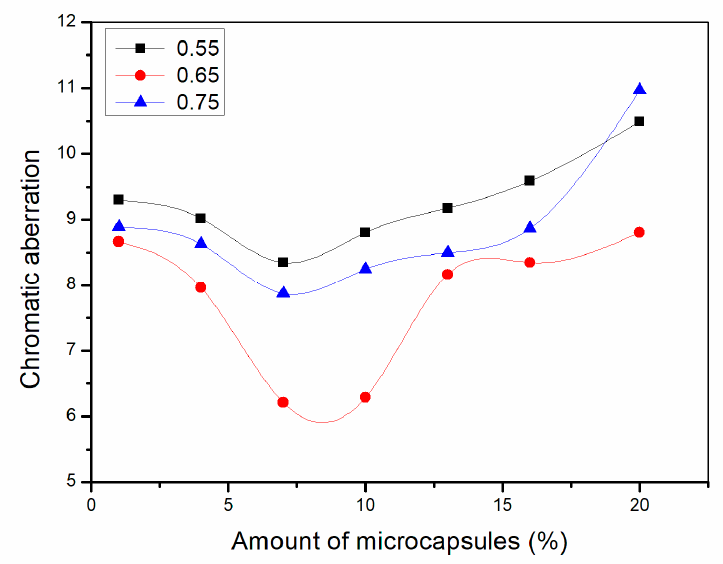
Figure 13. Chromatic aberration of the coating after drying at 140 °C for 2 h.